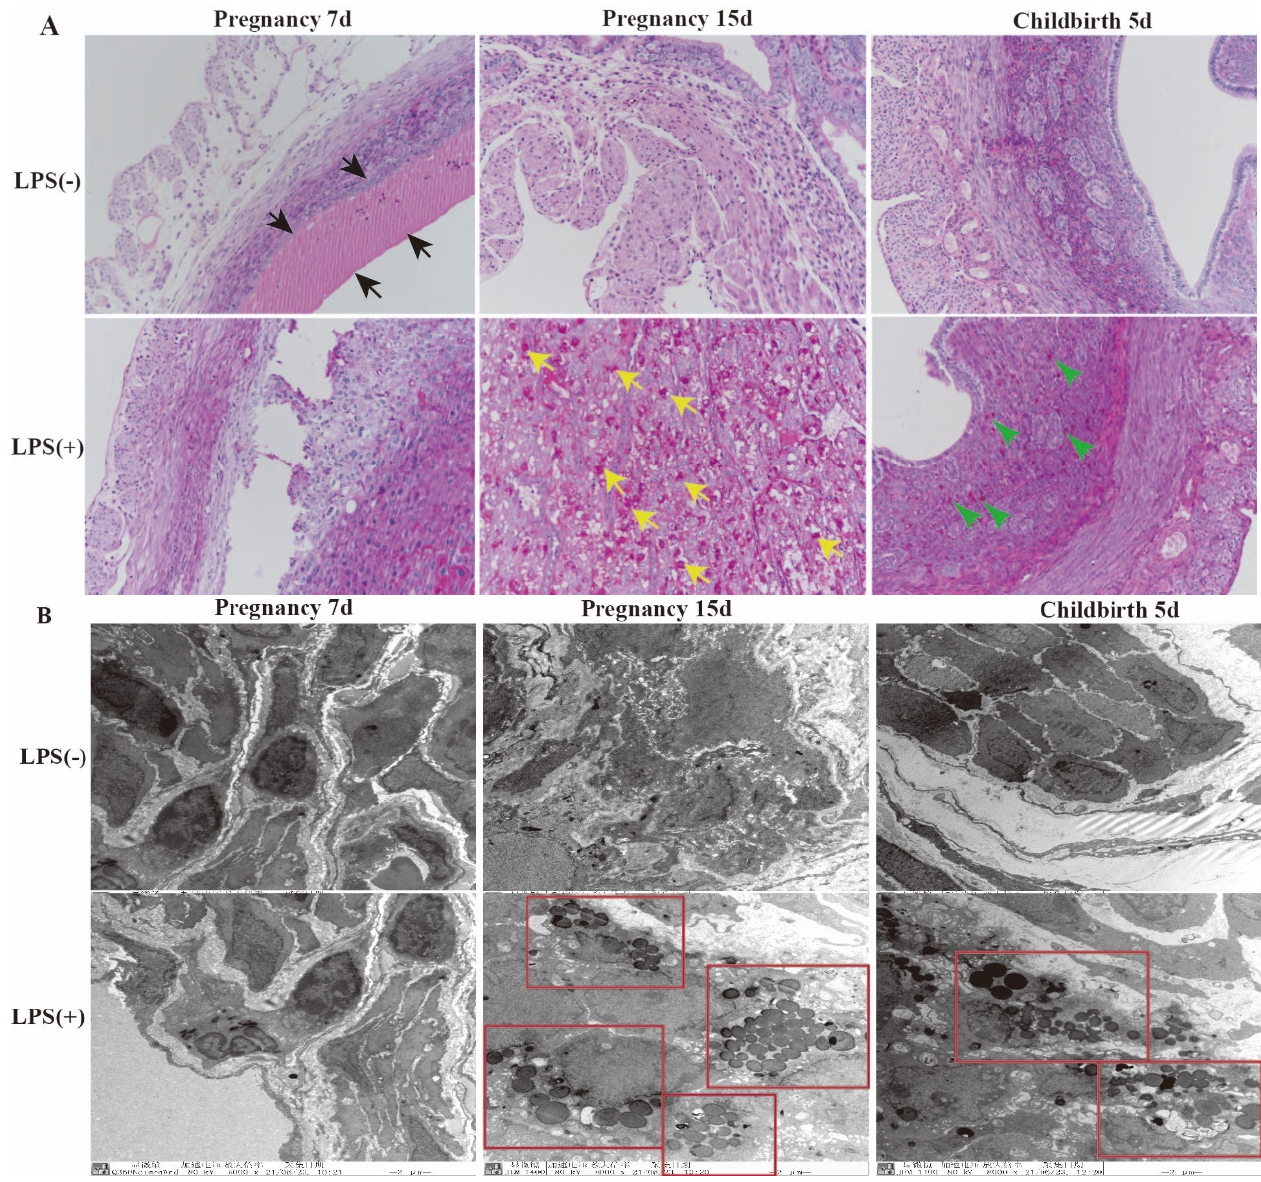
Figure 3. Effect of LPS on histomorphology and ultrastructure of uterus in mice. At days 7 of pregnancy, the thickness of the mucous layer of the uterus in mice in the LPS (-) group (black arrow). At day 15 of pregnancy, the endometrial glandular cells of the LPS (+) group secreted many glycosaminoglycan particles (yellow arrow). At 5 days after childbirth, the endometrial glandular cells of the LPS (+) group secreted few glycosaminoglycan particles (green arrow) ( A ) ( × 200). The ultrastructure of the uterus in mice at day 7 and day 15 of pregnancy and day 5 after childbirth ( × 8000). The endometrial glandular cells secreted more glycosaminoglycan particles at day 15 of pregnancy than at 5 days after childbirth in the LPS (+) group (red box) ( B